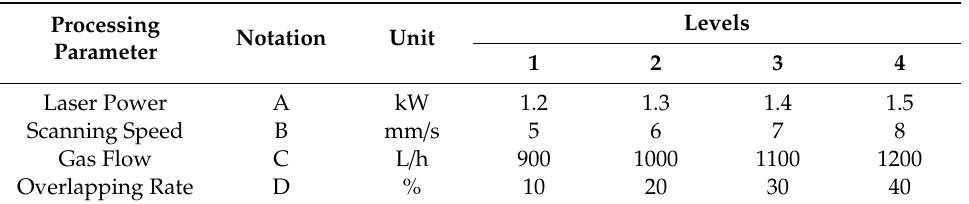
Table 2. Orthogonal experimental design.